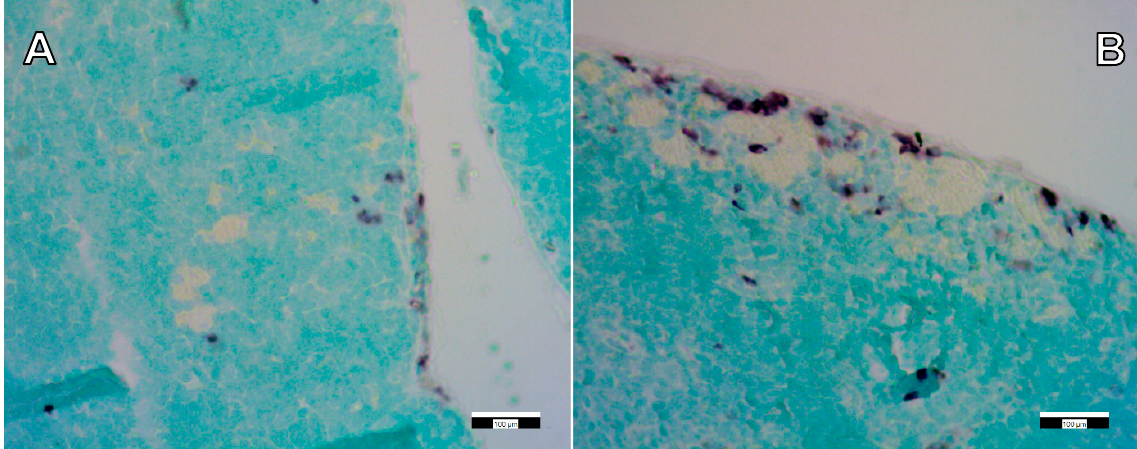
Figure 7. Immunohistochemical staining (CD68) of control ( A ) and “high dose” FSGM-treated ( B ) thymus tissue. Scale bars: 100 µm.